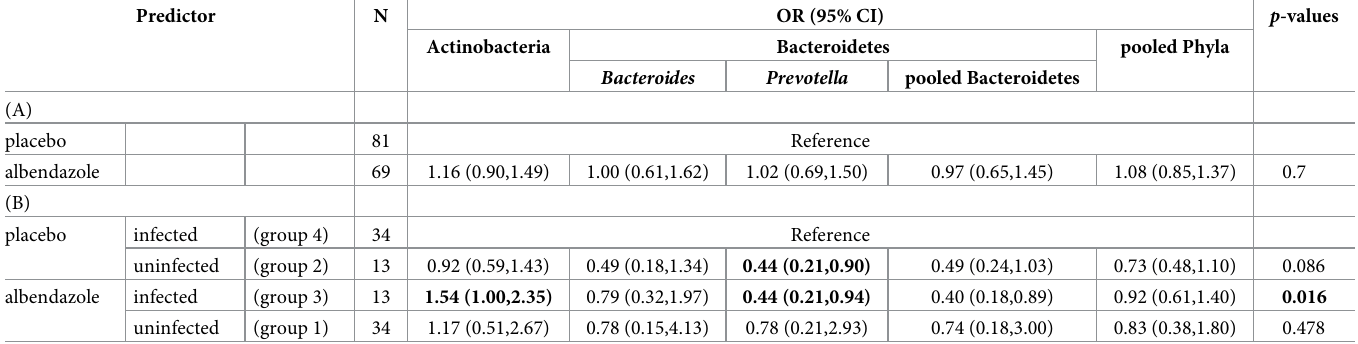
Table 3. The association between combination of bacteria taxa with treatment and infection at post-treatment.